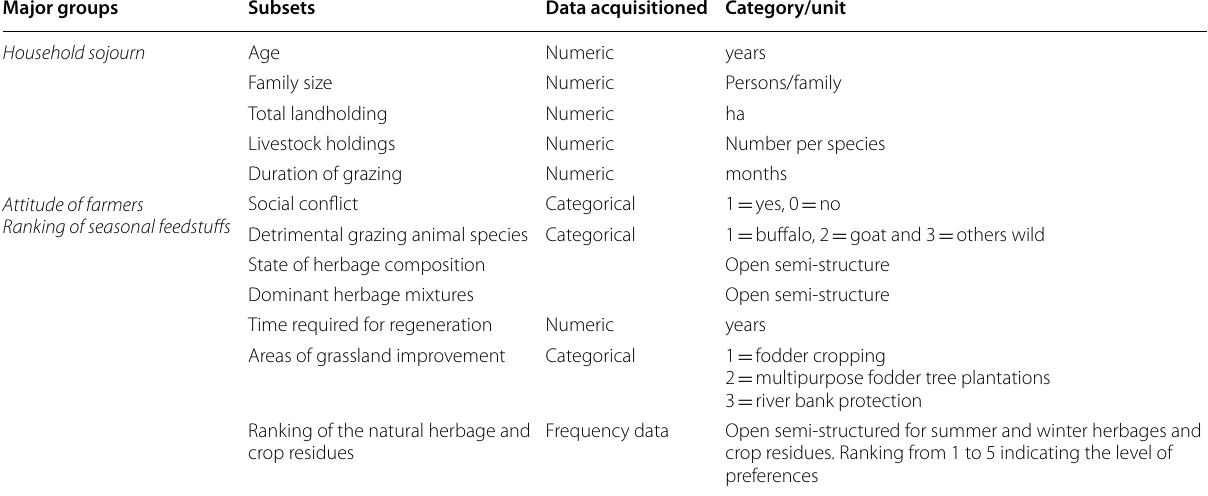
Table 1 Nature of questionnaires used to interview through semi-structured questionnaires survey in Madi, Chitwan, Nepal Major